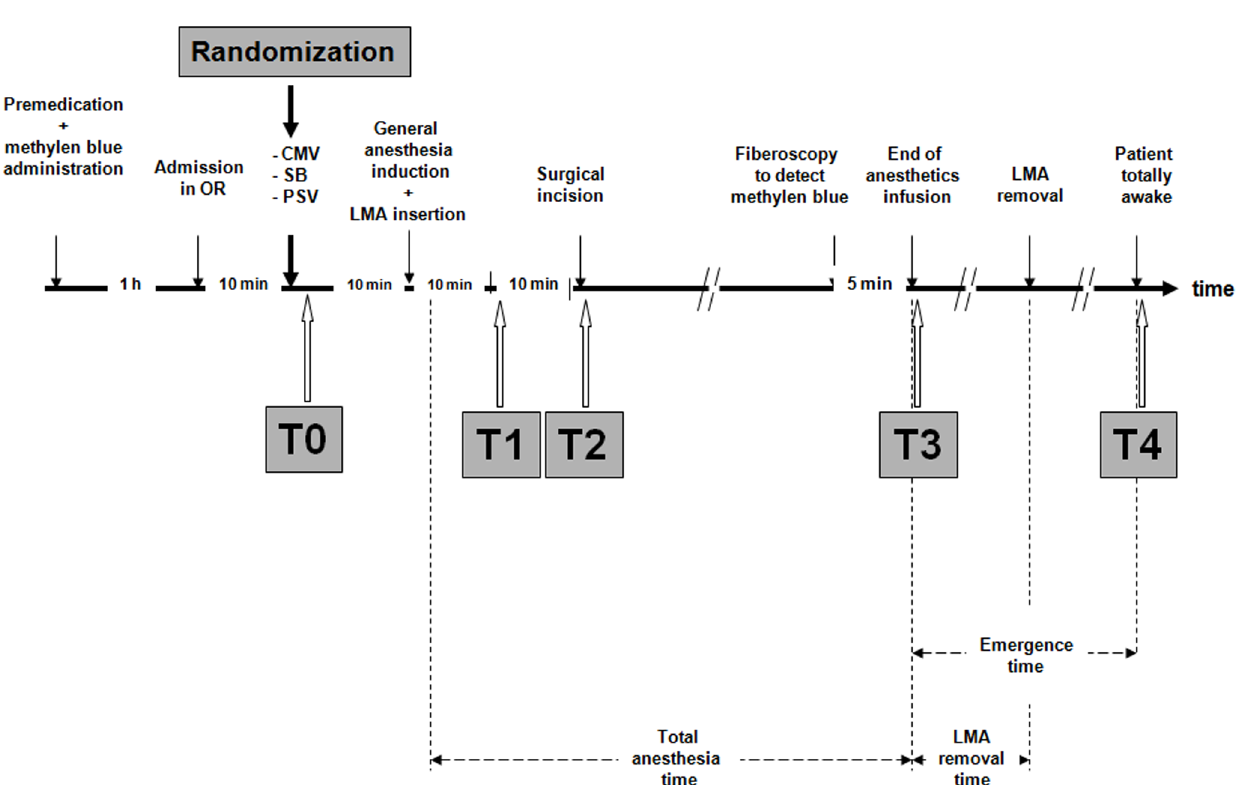
Fig. 1. Schematic illustration of the study design. Patient totally awake was defined as a patient who obtained a 10 point score on the five questions test (see